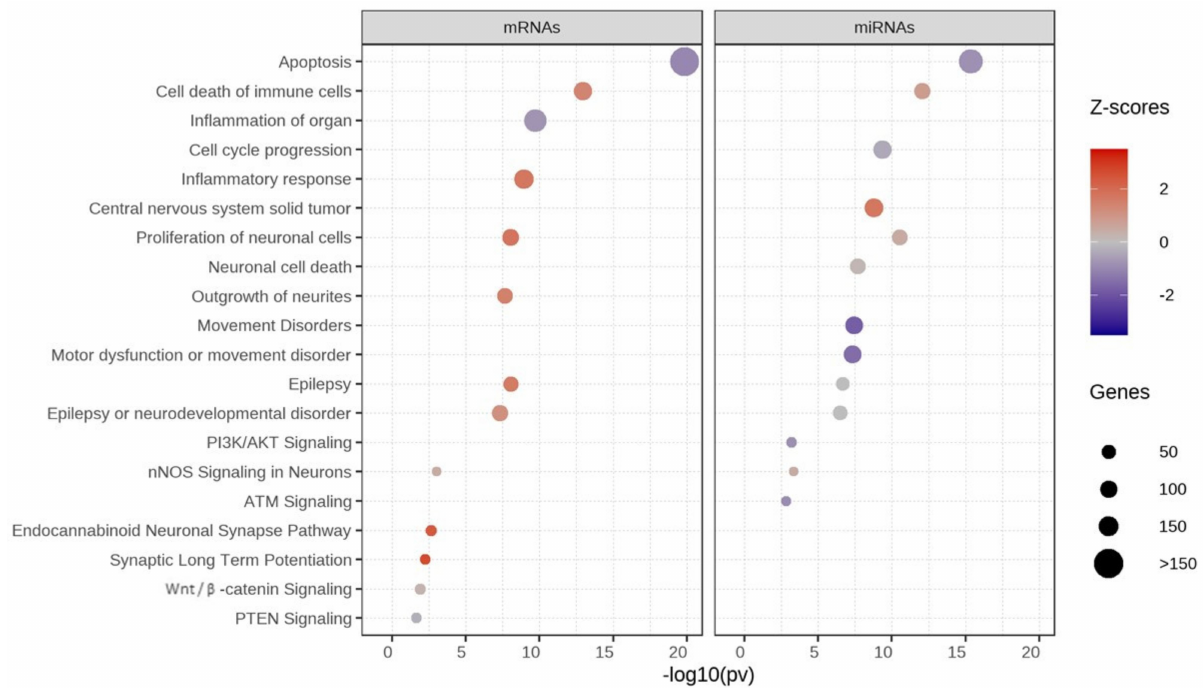
Figure 6. Pathway enrichment analysis of significant mRNAs and miRNAs-Ingenuity Path- way Analysis (IPA). Z-scores show activation or inhibition of pathways associated with autism. Red = activated pathway, blue = inhibited pathway, size of circle = number of